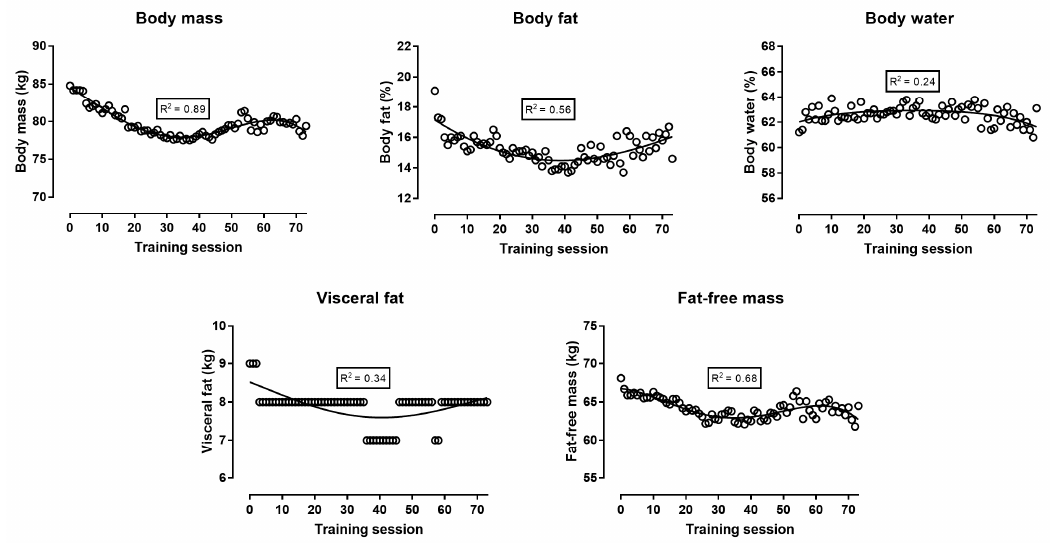
Figure 2. Body composition (i.e., mass, body fat, body water, visceral fat, and fat-free mass) during the preparation for a 48-hour ultra-marathon.